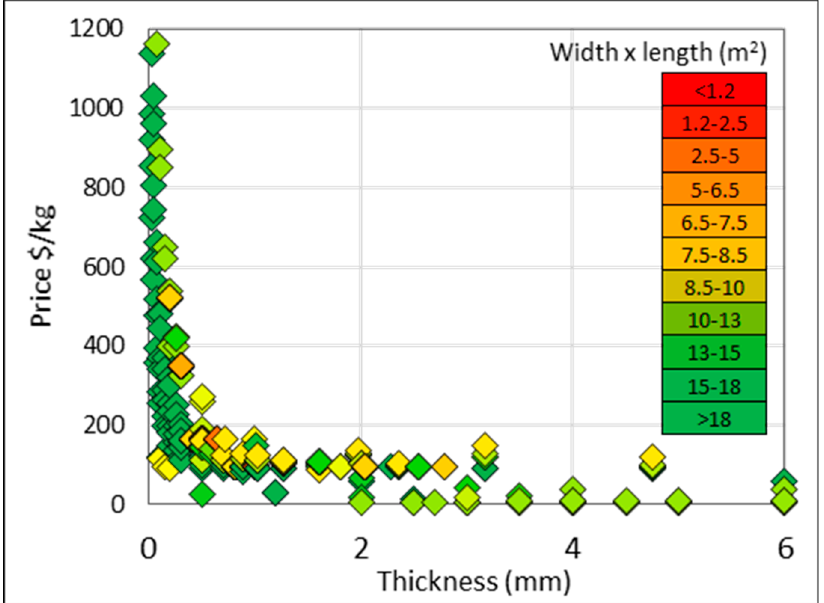
Figure 12. Price data for grades 1–4 titanium strip with width >120 mm and <660 mm, and length >500 mm. Width and length shown as color gradations.